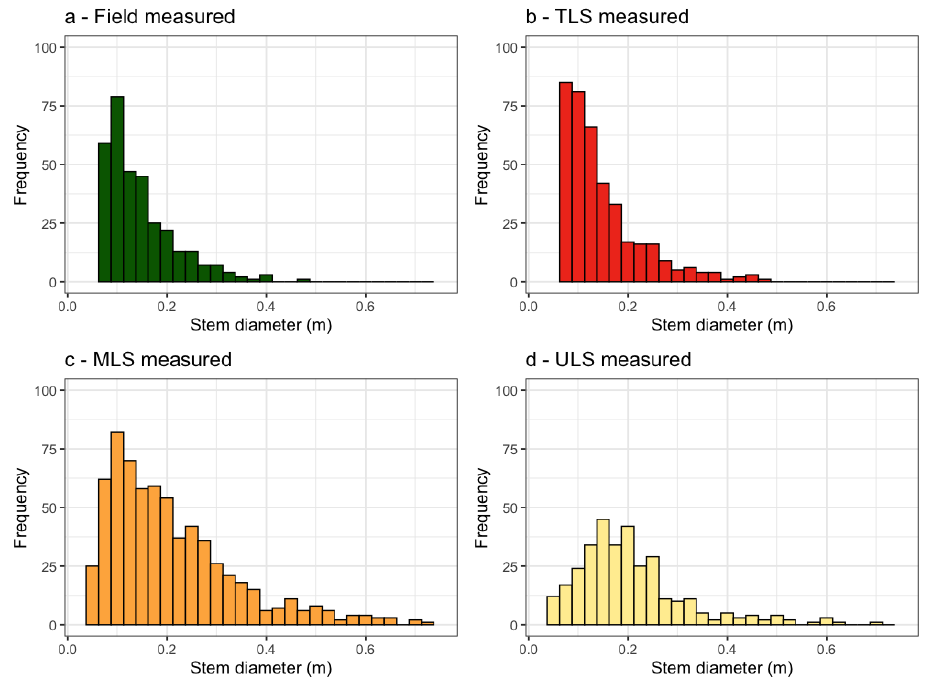
Figure 9. Distribution of DBH estimates from field inventory ( a ) and the three LiDAR approaches ( b – d